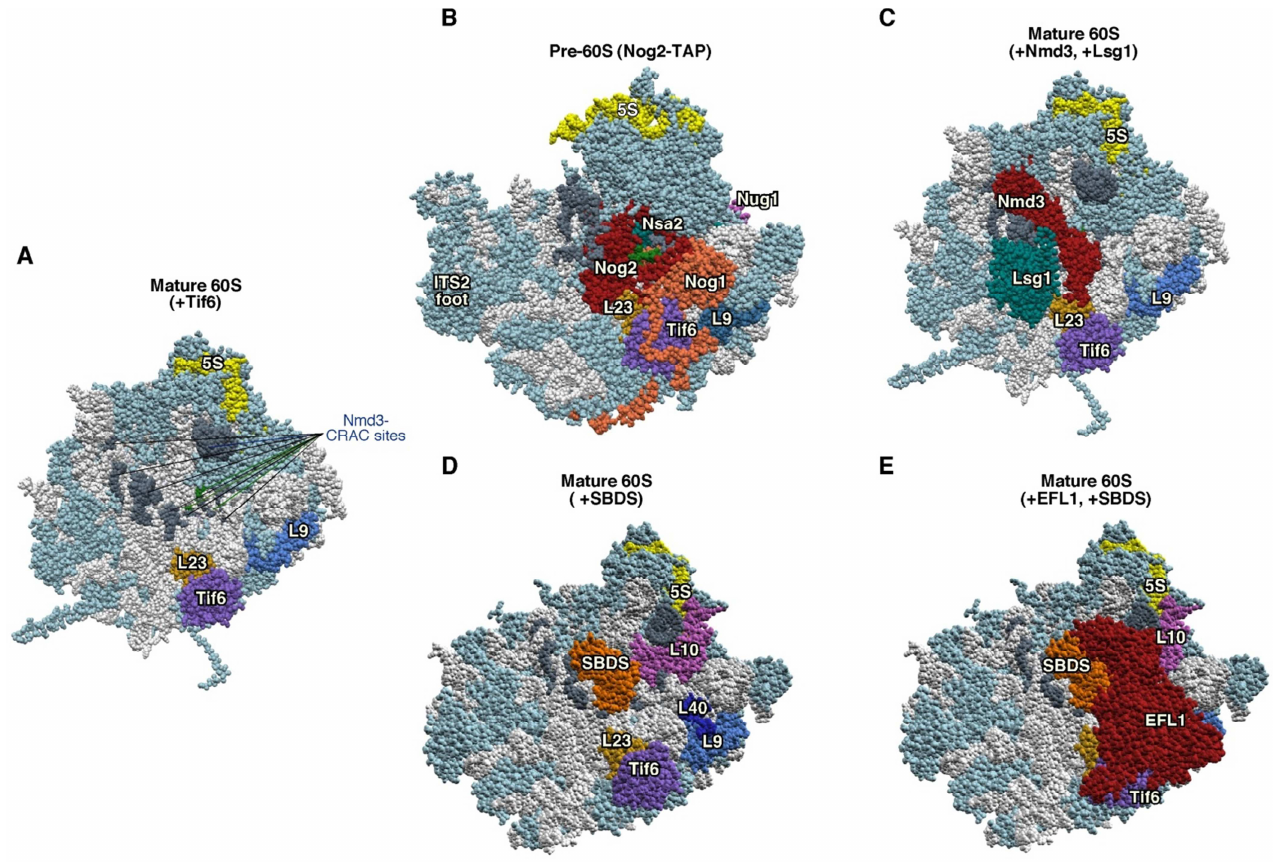
Figure 5: Interactions at the interface side of cytoplasmic pre-60S ribosomal particles. (A) The Nmd3-binding sites, identified by CRAC at 25S rRNA helices H38, H69-69 and H89-90 [115], have been highlighted in dark grey in a reconstituted 60S r-subunit (PDB ID:5T62; [114]). The CRAC sites common for Nmd3, Dbp10 and Nug1 [115, 118] are labelled in green. (B) Position of Nog2 (red), Nsa2 (blue), Nog1 (gold) and Nug1 (pink) in the early pre-60S r-particle purified with Nog2-TAP (PDB ID: 3JCT; [40]). Note that only a very small portion of Nug1 has been resolved in this particle. (C) Position of Nmd3 and Lsg1 in a reconstituted 60S r-subunit (PDB ID:5T62; [114]). Note that only the region of Nmd3 comprised between residues 46 and 388 of 518 in total is shown. The N-terminal end of Nmd3 approaches to Tif6 while the C-terminal end contact L1. In A-C, the position of Tif6 (purple) is shown. The locations of the 5S rRNA (yellow) and that of the L23 (gold) and L9 r-proteins (royal blue) have also been highlighted. (D) Position of SBDS (dark gold) in the 60S r-subunit. The structure of a pre-60S r-particle from Dyctiostelium discoideum containing Tif6 and reconstituted with human SBDS and EFL1 (PDB ID: 5ANB; [116]) was superimposed on the structure of yeast 60S r-subunit (PDB ID: 5APN; [68]); then, all common proteins from D. discoideium were removed from the model. L9 (royal blue), L40 (navy blue), L10 (violet), L23 (gold) and 5S rRNA (yellow) were highlighted. Note that SBDS is shown in its open conformation state. (E) As D, but additionally showing EFL1 (red) on top of Tif6. In all figures, the Nmd3-CRAC sites shown in A (dark grey) were also highlighted, the rest of rRNAs are coloured in pale blue and the rest of r- proteins and/or factors in light cornflower